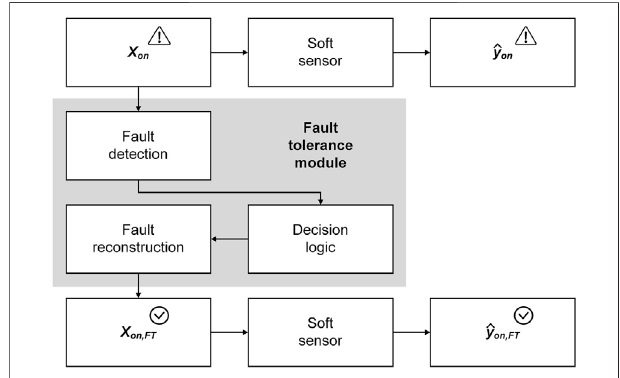
FIGURE 5 | Concept of a fault tolerance module for creating a fault- tolerantsoft sensor. When afaultoccursin oneor multiplevariables ofthesoft sensor inputs X on , usually the soft sensor prediction (cid:1) y on is also faulty dependent on the degree of in fl uence of the variable(s) in the soft sensor model (upper branch). Fault-tolerant soft sensors are capable of compensating for faults in the inputs by the following procedure: Initially, the sensor fault is detected. Then, a decision logic determines whether or not to reconstruct thefaultysensorreading. Thisreconstruction resultsinafault-free substitute for X on , namely, the fault-tolerant inputs X on , FT . The soft sensor uses these inputs for the determination of a fault-tolerant output (prediction) (cid:1) y on , FT